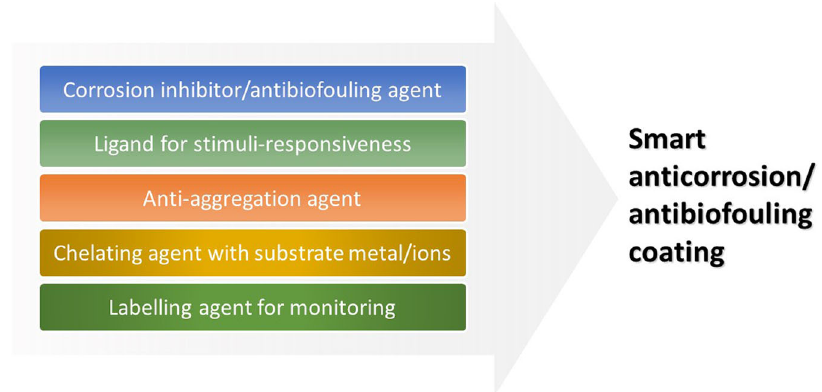
Fig. 2 A potential list of components for loading/conjugation with organic